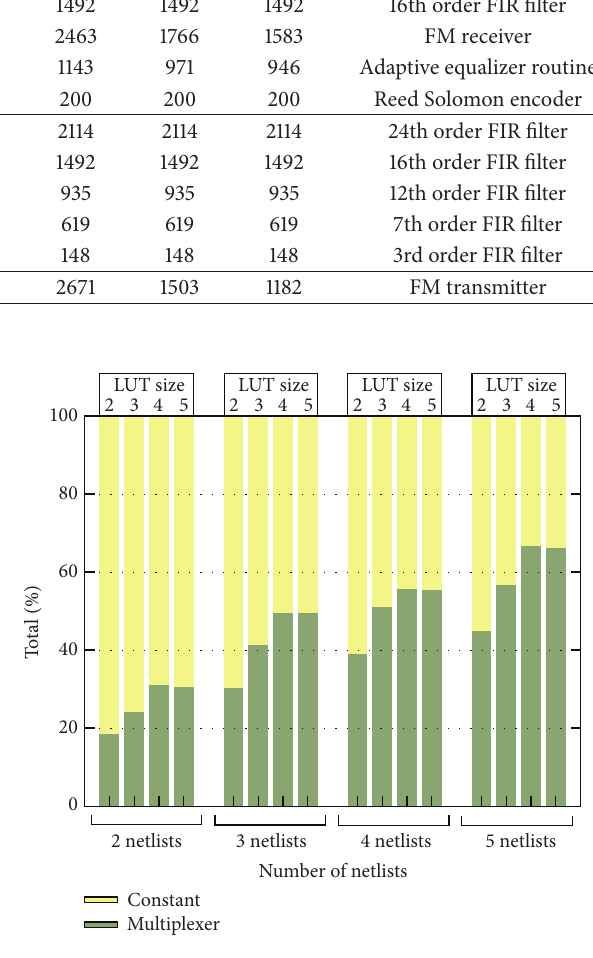
Figure 17: Percentage of replaced SRAM distribution for